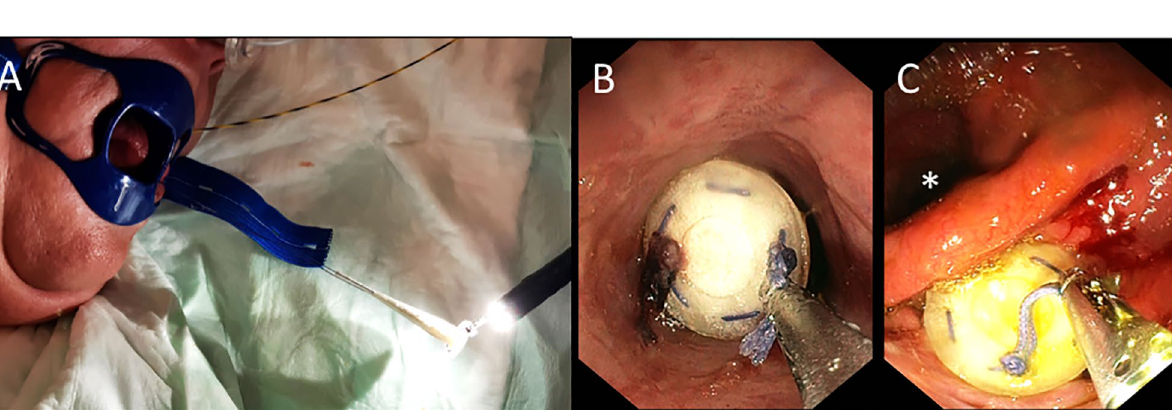
Figure 2. Two different types of plugs. ( A ) A modified Biodesign Fistula Plug (Cook), ( B ) self-made plug with waterproof cap and resorbable cone by Vicryl mesh. The base plate is sealed with bone wax (*). For endoscopic implantation, a strap with an absorbable suture is sewed inside the waterproof basis plate (yellow arrow) that can be grabbed by the endoscopic forceps and one strap at the tip of the plug (red arrow).